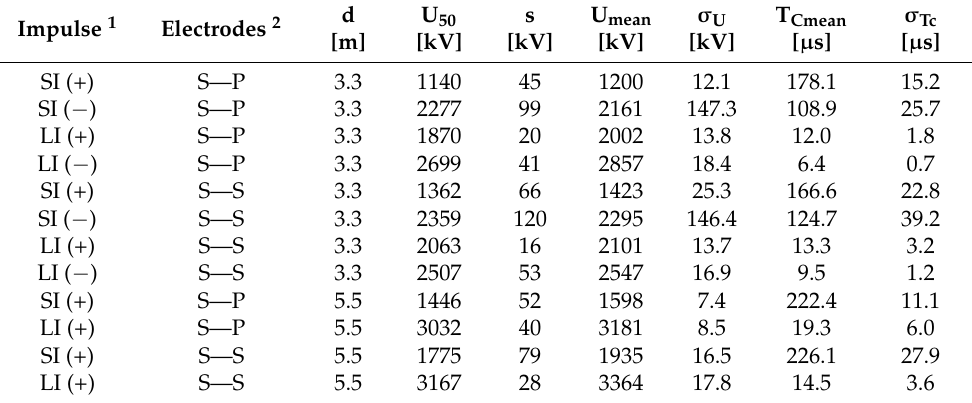
Table 2. Test voltage parameters for each test configuration: d—distance between electrodes, U 50